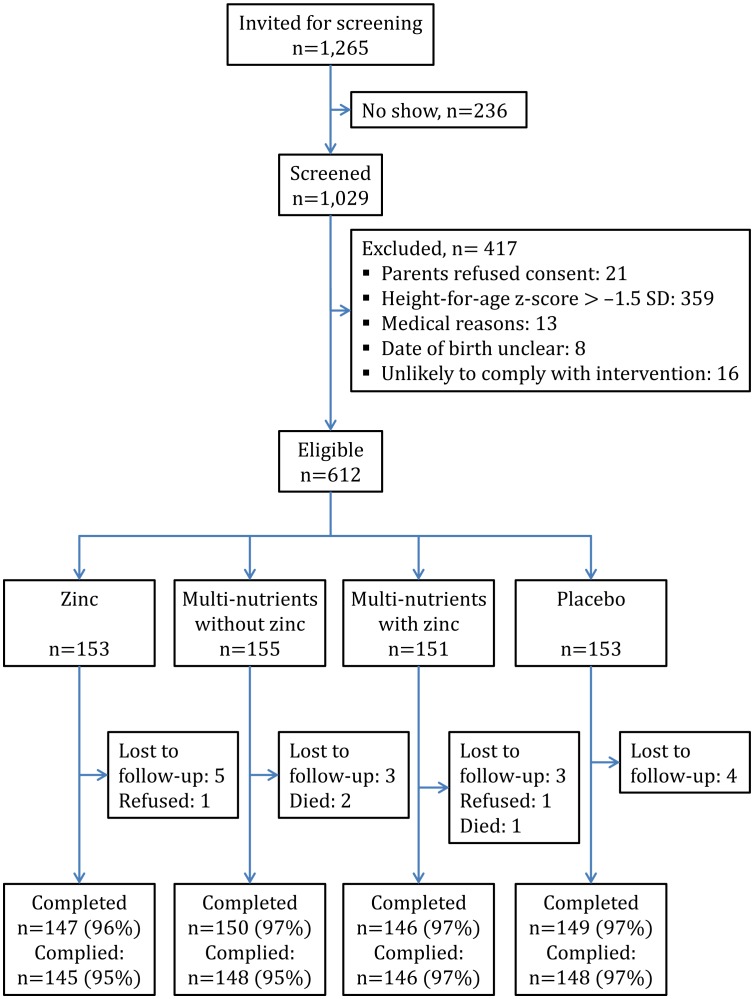
Trial profile.Compliance was measured as the proportion of children who consumed.95% of scheduled supplements.